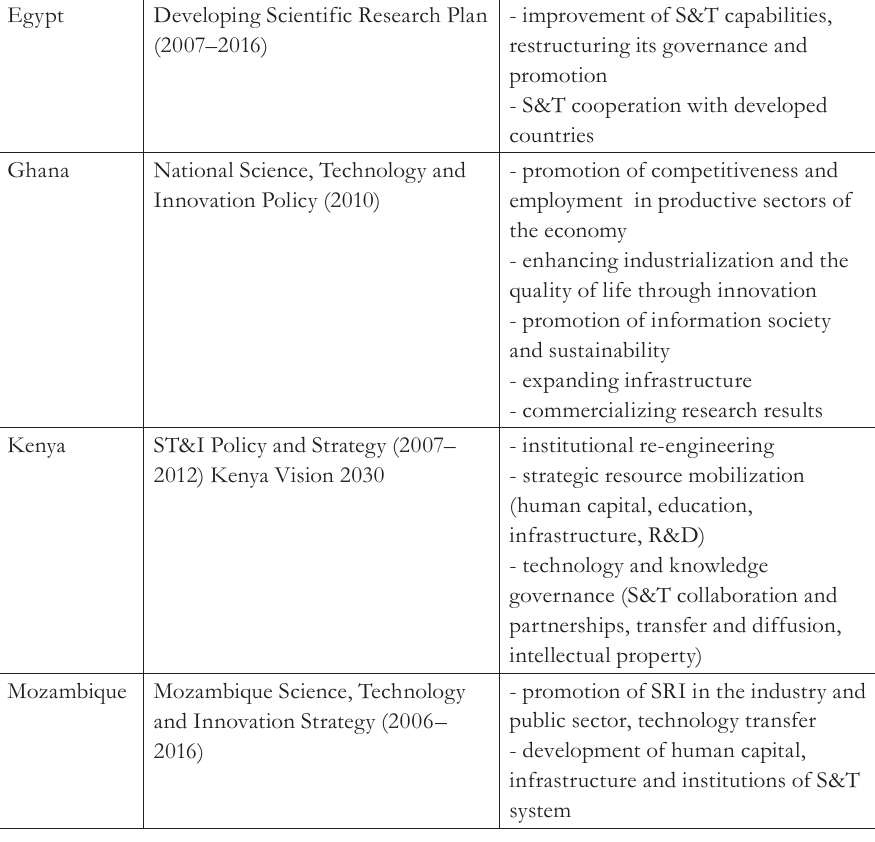
Tab. 1 – STI policies, strategies and plans in selected African countries. Source: Own elaboration based on NPCA